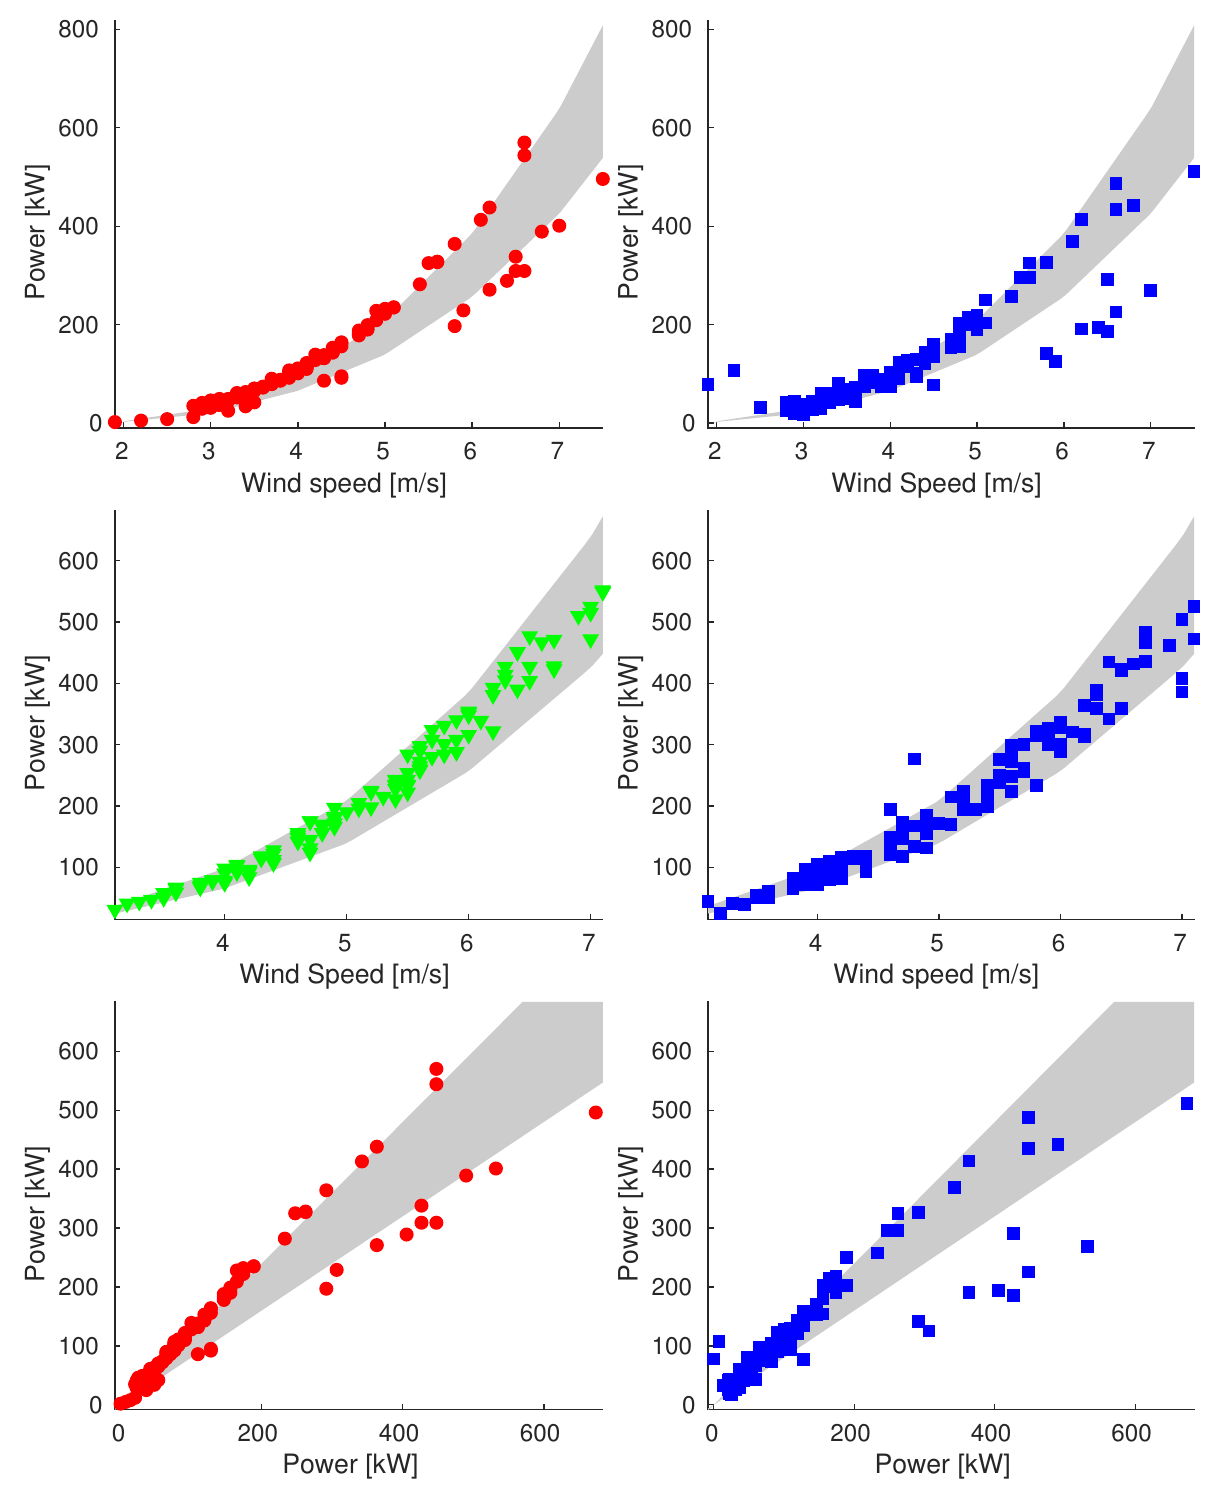
Figure A8. Plot of reconstructions for data points of 24 September ( Sample_90 ). We compare original data (on the left ) and reconstructed values (on the right ). We show plots of power vs.wind speed of rejected and validation data ( up and middle respectively) and plot of power vs.ideal power of rejected data ( bottom